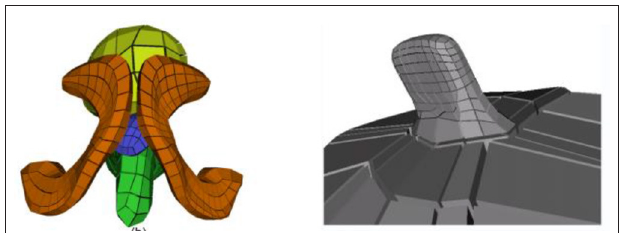
FIGURE 14 | Left: Finite elements for objects in the male pelvis. Right: finite elements for a host figure and subfigure (Crouch et al., 2007).